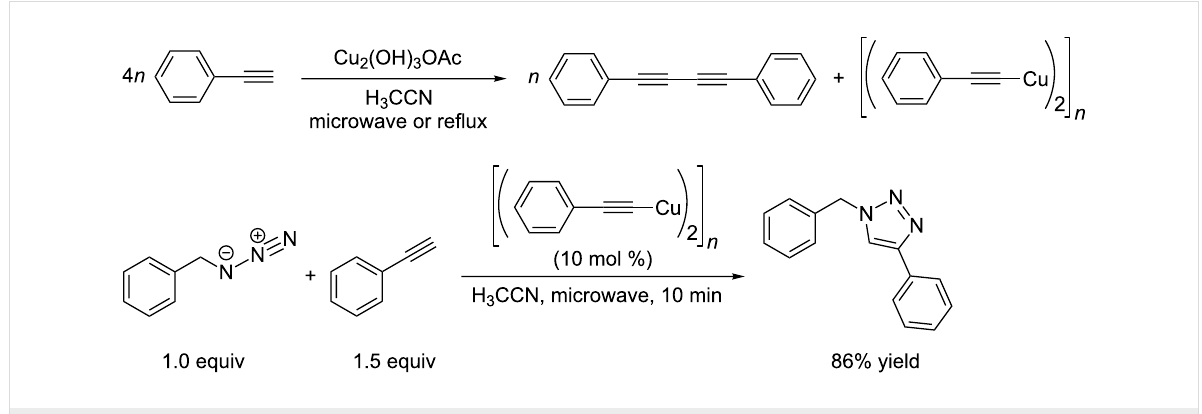
Scheme 23: Synthesis of [(PhC ≡ CCu) 2 ] n as co-product in the Glaser coupling of phenylacetylene in the presence of copper(II) hydroxyacetate in acetonitrile, and application of [(PhC ≡ CCu) 2 ] n as catalyst in the CuAAC test reaction of phenylacetylene with benzyl azide